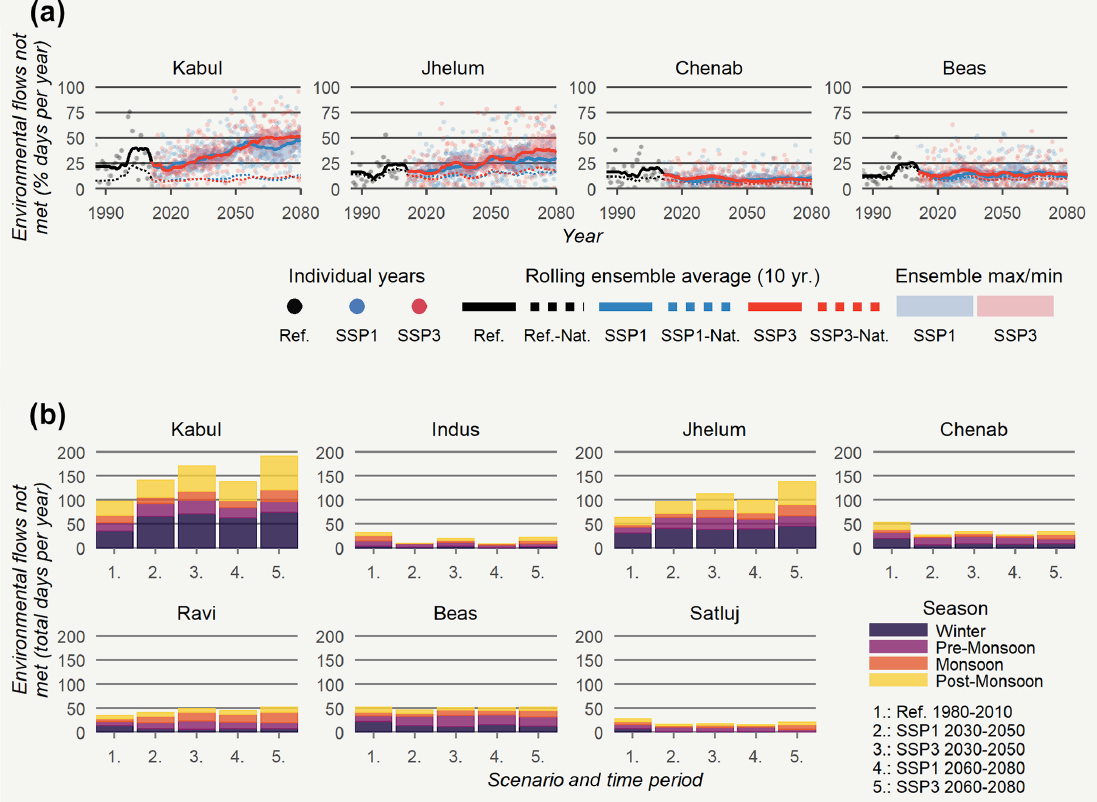
Figure 5. Impact of upper Indus consumption on environmental flows at the outlet of the upper Indus sub-basins over the assessment period (a) and per season (b)